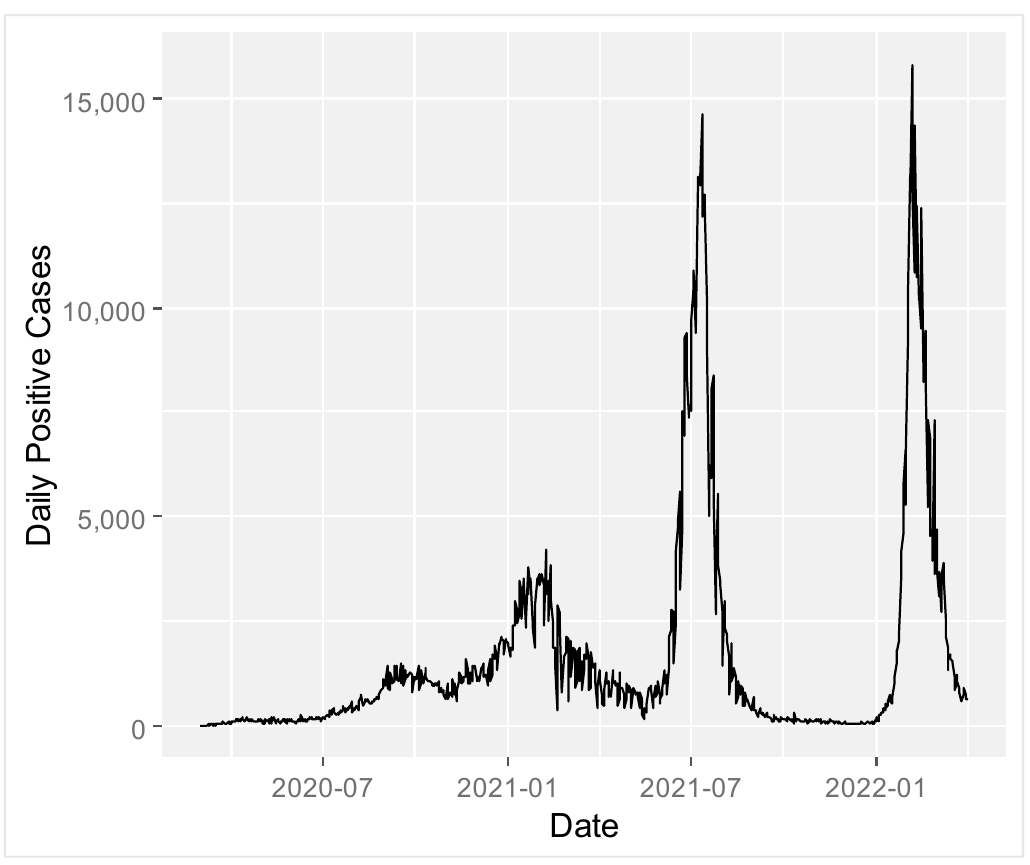
Figure 1. The daily new cases from 2 March 2020 to 3 April 2022, in Jakarta.